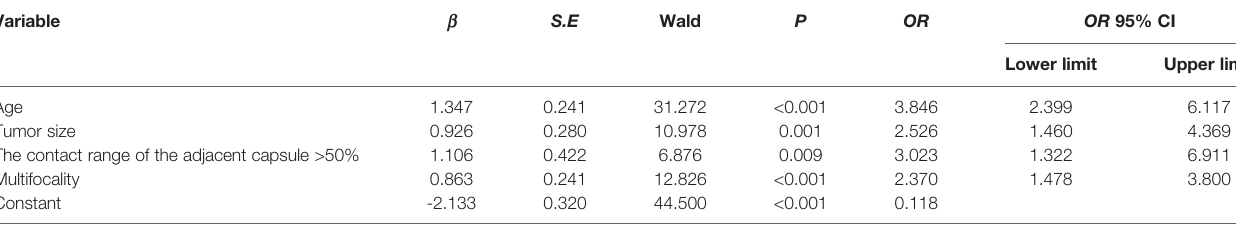
TABLE 5 | Logistic regression analysis of cervical lymph node metastasis in PTC. Variable